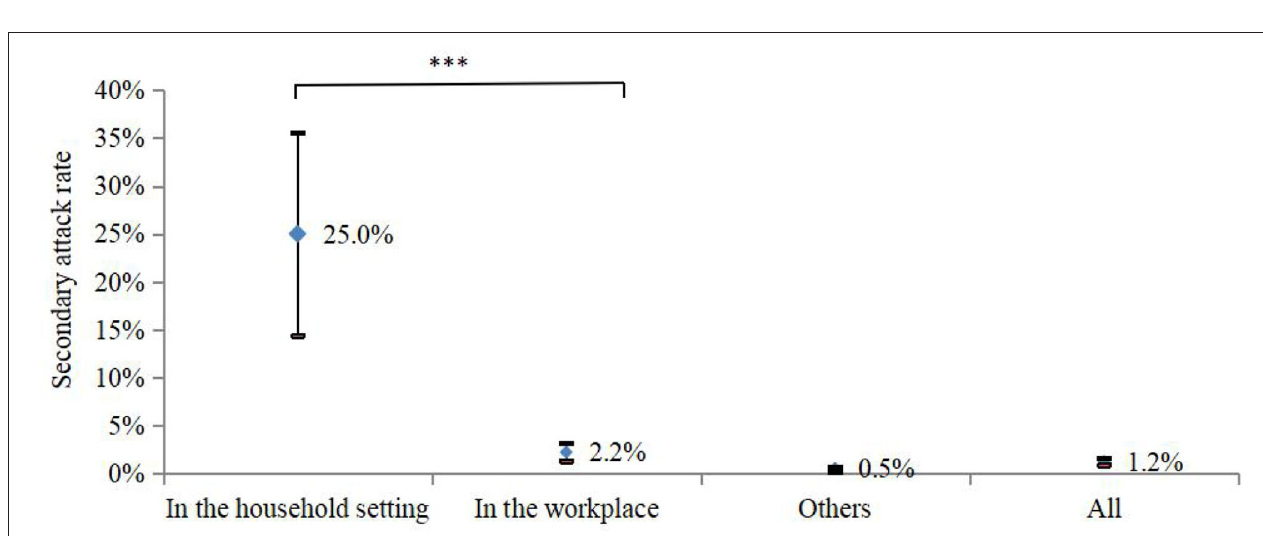
FIGURE 3 | SAR occurred in the different settings in Jingmen City, Hubei Province, China in August 2021. *** p <